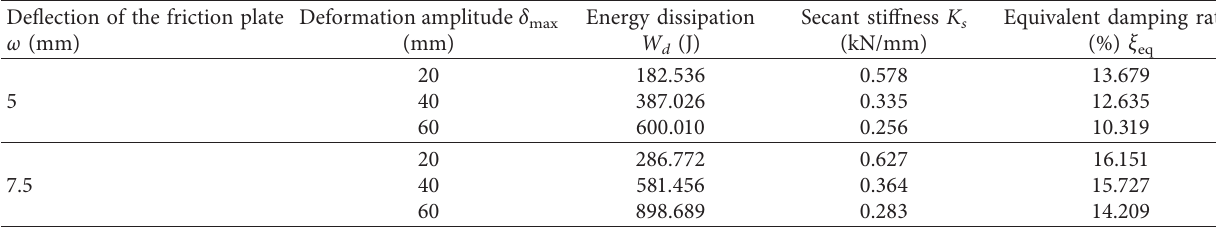
Table 6: Performance parameters under various deformation amplitudes (SCVF brace with spring S2). Deflection of the friction plate ω (mm)